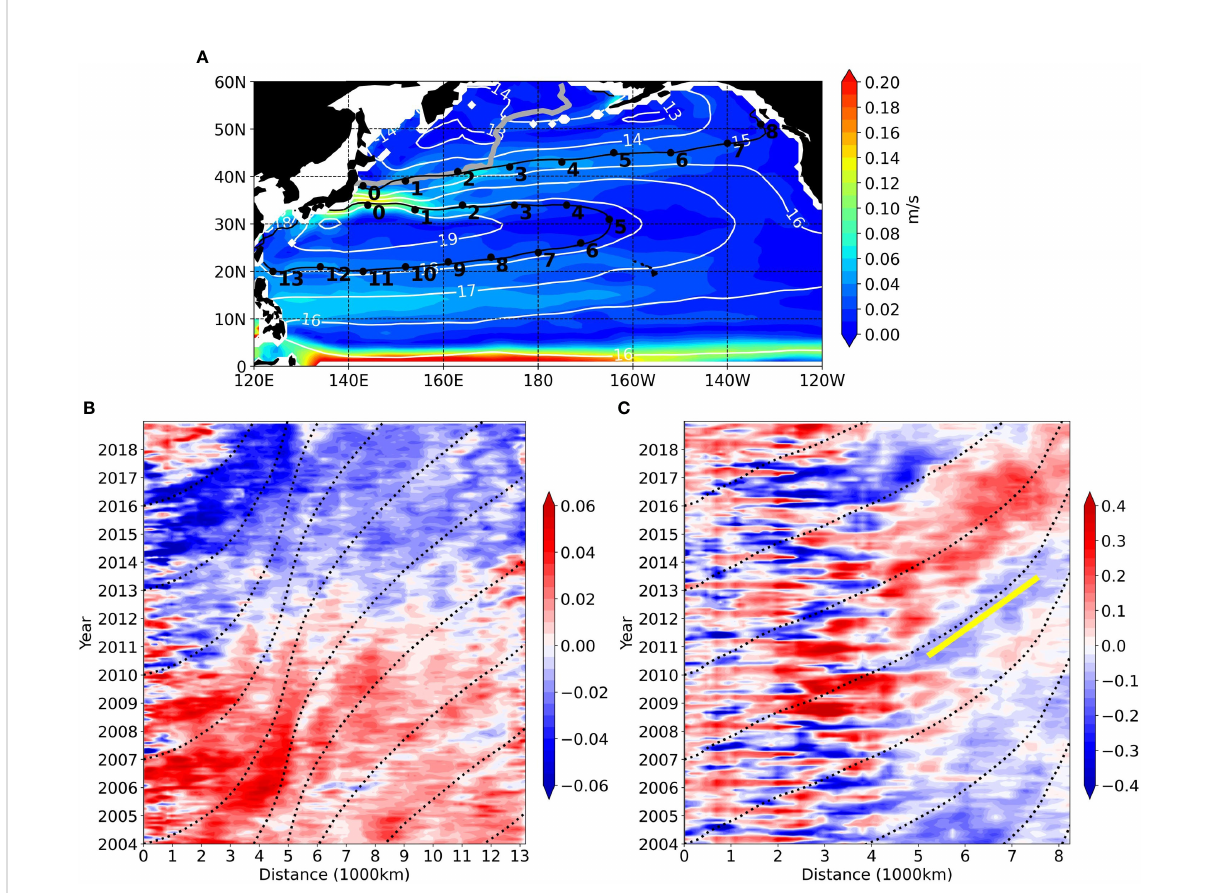
FIGURE 12 Same as in Figure 10 but on g = 26.3 surface along (B) 18.2 and (C) 15 stream funtion isopleths. The yellow line indicates a speed of 0.03